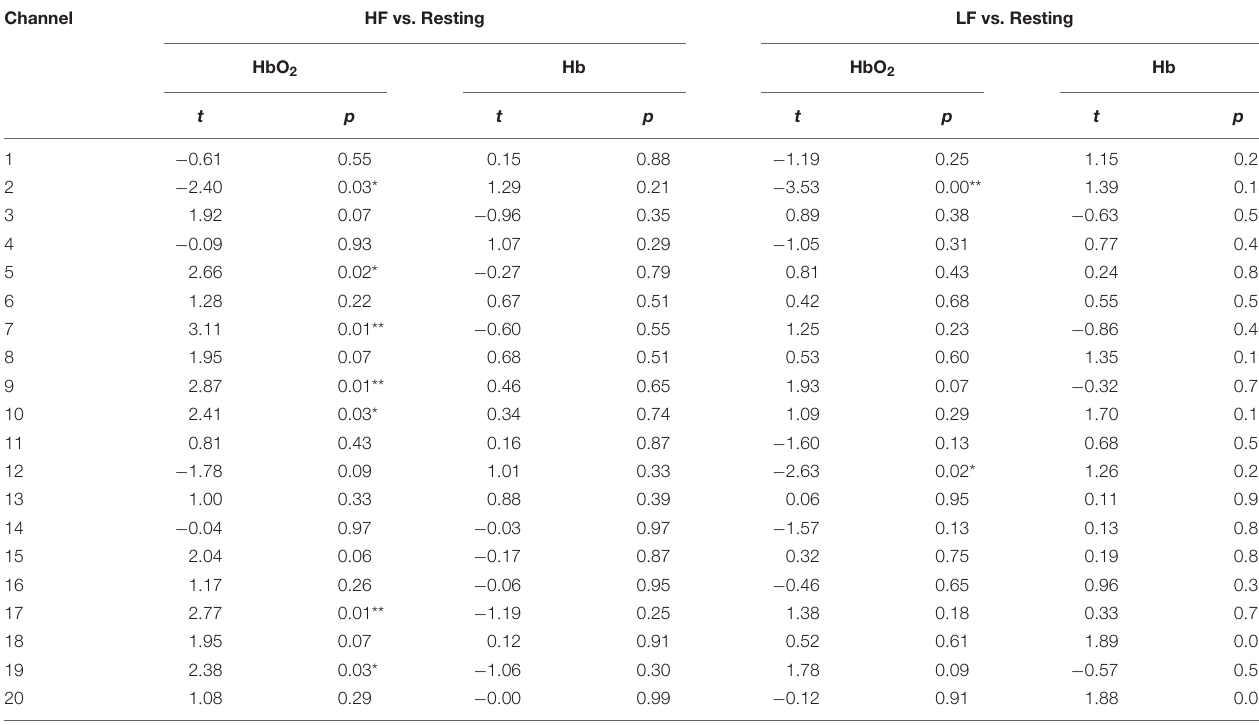
TABLE 2 | HbO 2 and Hb t and p statistics for high frequency (HF) versus resting, and low frequency (LF) versus resting conditions for the normal controls. Channel HF vs. Resting LF vs. Resting